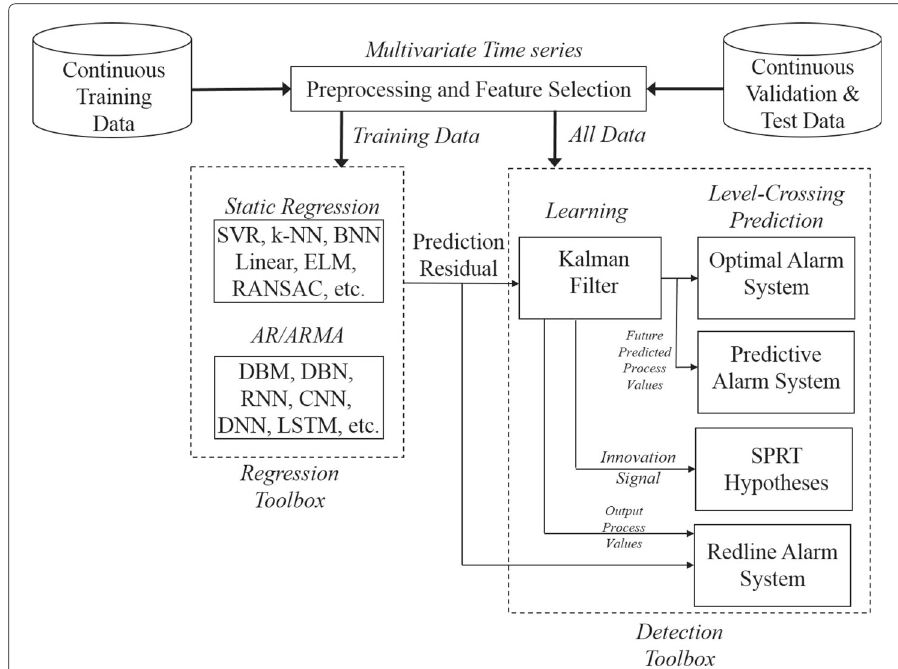
Fig. 3 Functional architecture of ACCEPT(Martin et al. 2015). All data can be pre-processed and then training